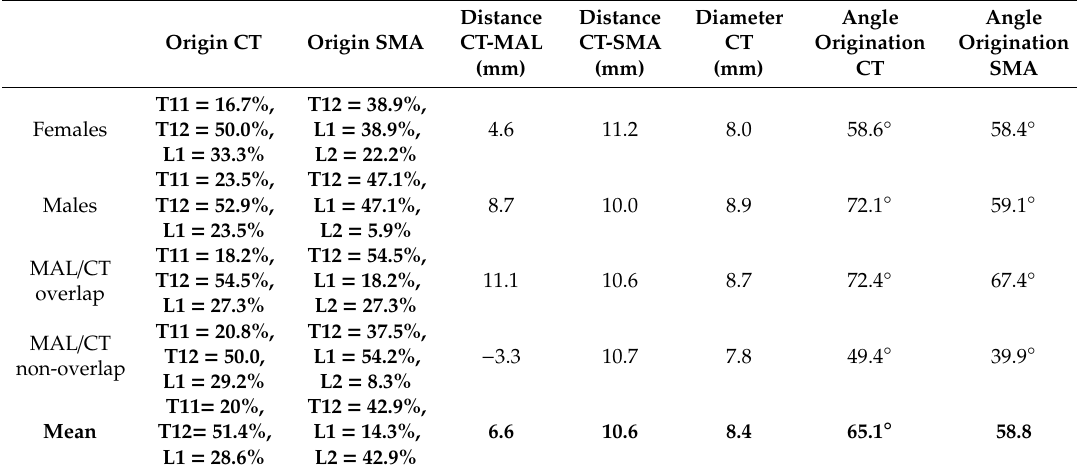
Table 1. Cadaveric data on anatomical variables measured broken down by sex and MAL / CT overlap status.